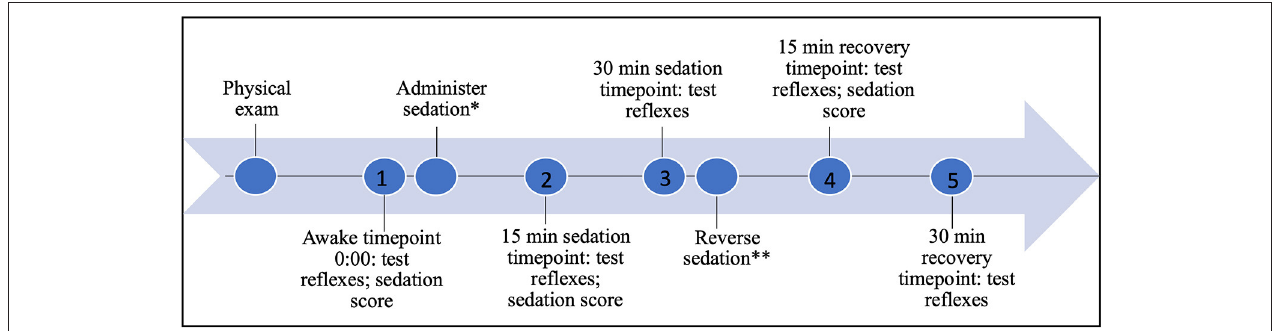
FIGURE 1 | Timeline of testing, sedation, and recovery; *0.3 mg/kg butorphanol and 3 mcg/kg dexmedetomidine IV; **0.03 mg/kg atipamezole IM; 1 awake timepoint 0:00; 2 15min sedation timepoint 0:15; 3 30min sedation timepoint 0:30; 4 15min reversal timepoint 0:45; 5 30min reversal timepoint 1:00.